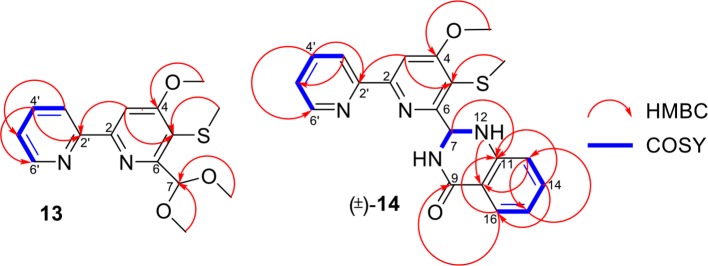
Key 1H-1H COSY and HMBC correlations of 13 and (±)-14.